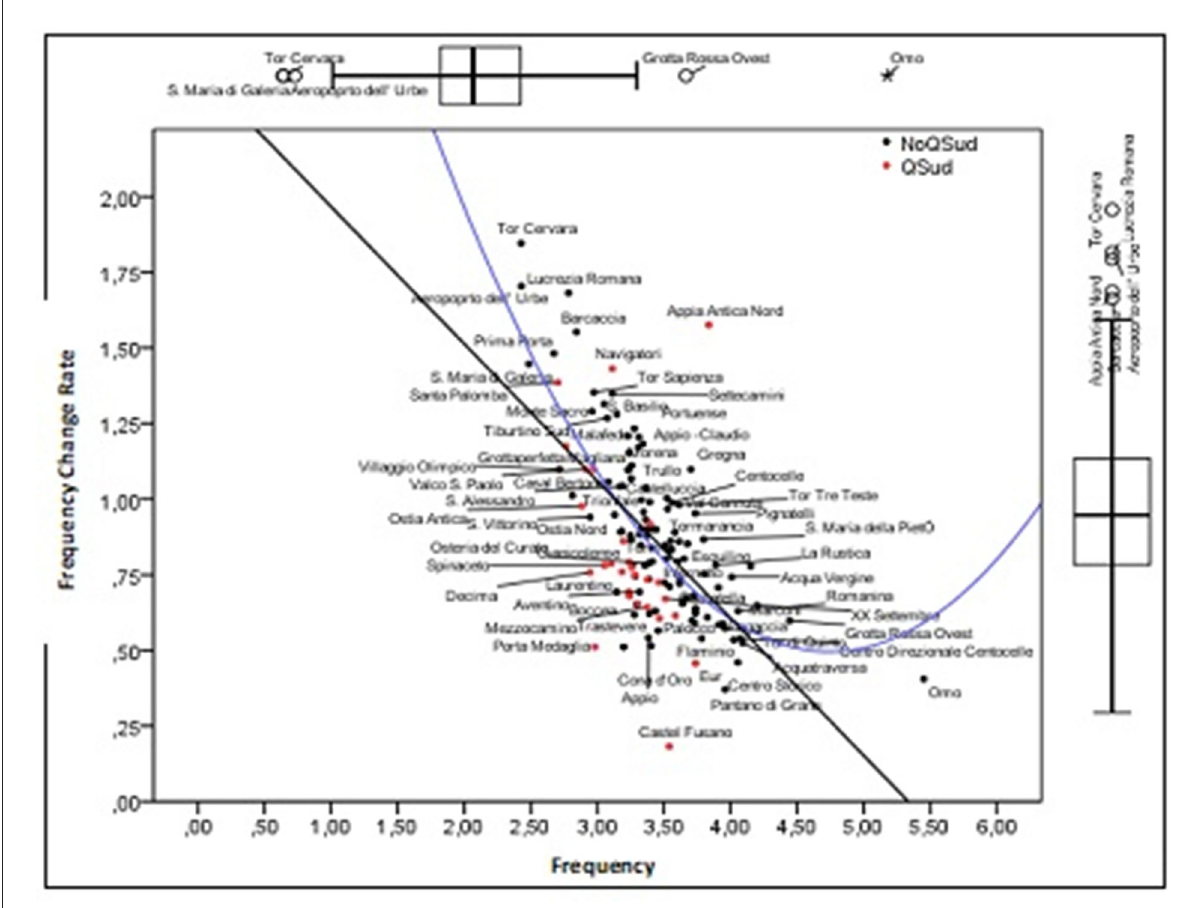
FIGURE4 Univariate and bivariate features of the distribution of IC and